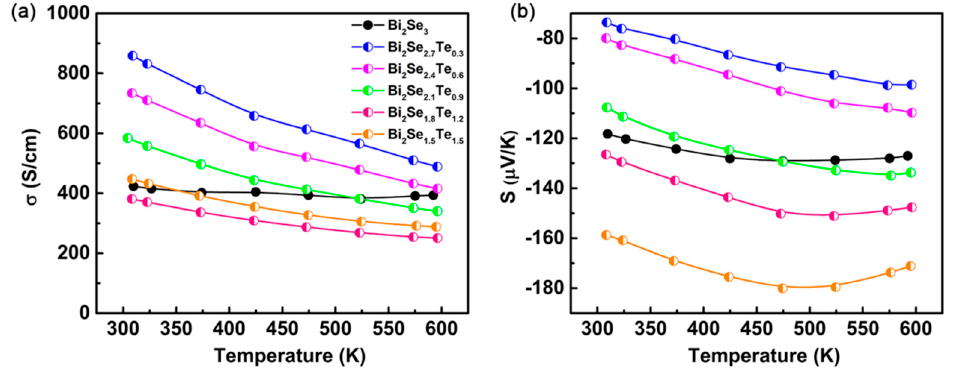
Figure 2. Temperature dependence of ( a ) electrical conductivity and ( b ) Seebeck coefficient for Bi 2 Se 3 − x Te x